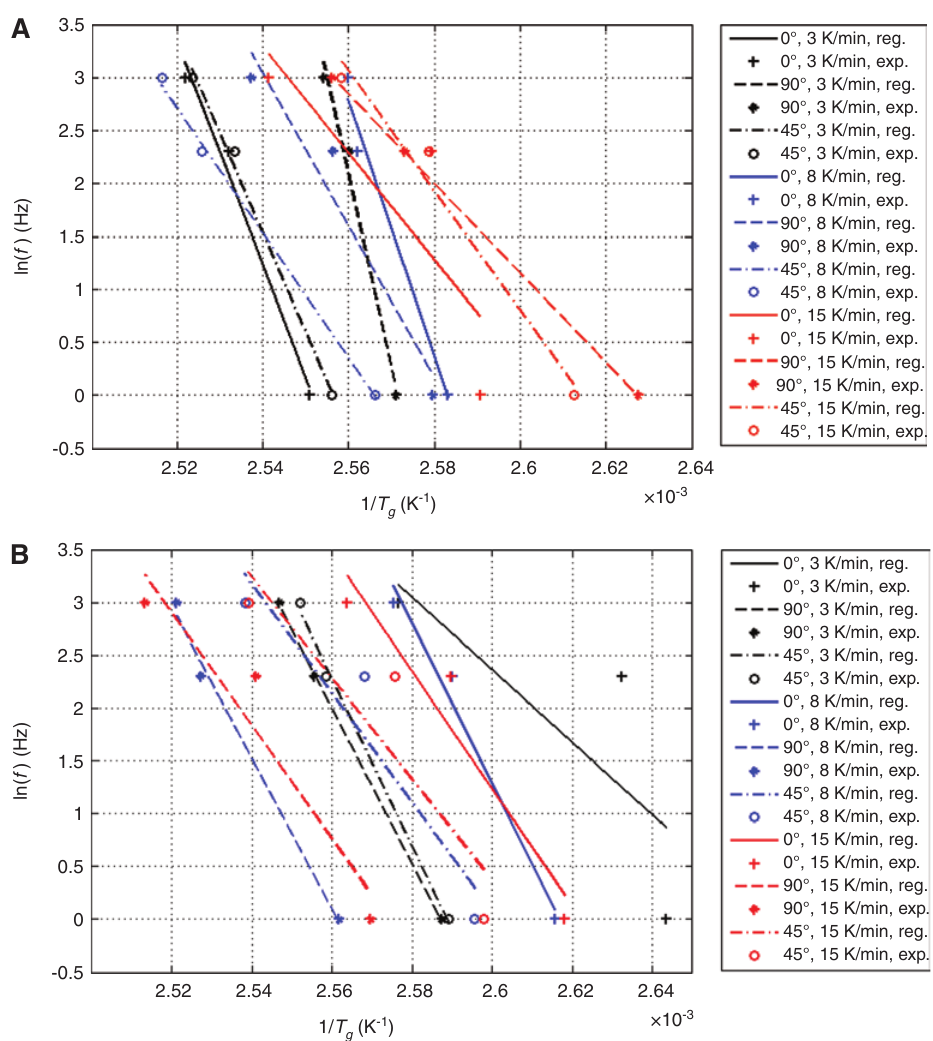
Figure 3: Arrhenius plots for GFRP and